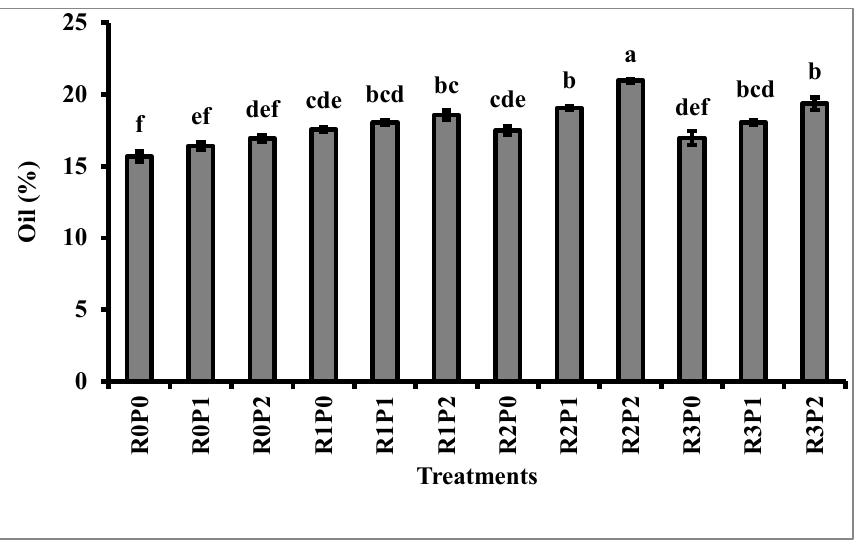
Figure 5. Interaction effect of Rhizobium japonicum and Pseudomonas striata on oil content of soybean. R 0 : Control (no nitrogen and R. japonicum ), R 1 : 100% N without R. japonicum , R 2 : 50% N with R. japonicum , R 3 : only R. japonicum inoculant, P 0 : Control (no P and no P. striata ), P 1 : 100% P without P. striata and P 2 : 75% P with P. striata . Mean values sharing similar letters are statistically insignificant. Two-way ANOVA showed a significant interaction ( p ≤ 0.05) between R. japonicum and P. striata .